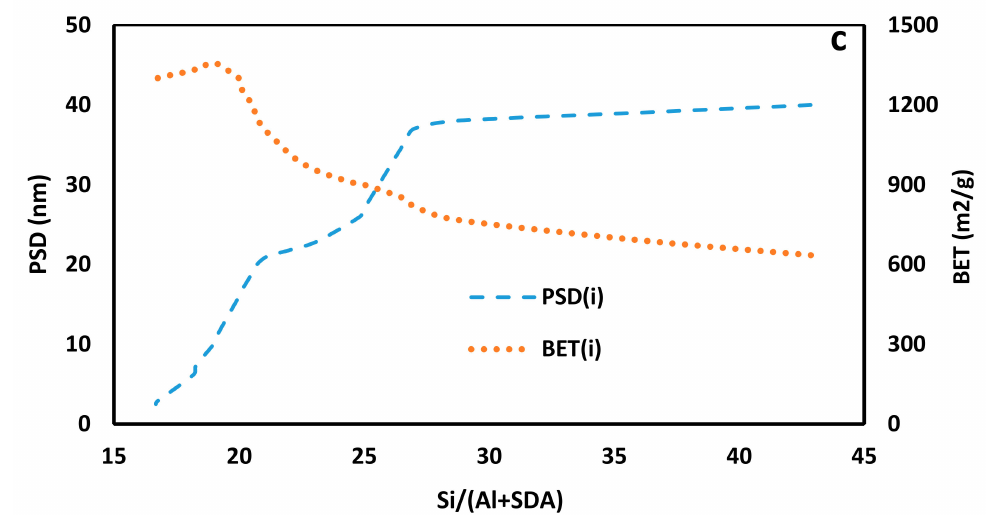
Figure 2. ( a ) N 2 -adsorption/desorption isotherms and ( b ) barrett–joyner–halenda (BJH) pore diameter distributions, of the synthesized optimum supports and ( c ) effect of Si/(Al + SDA) on the PSD and BET for Tetrapropylammonium hydroxide